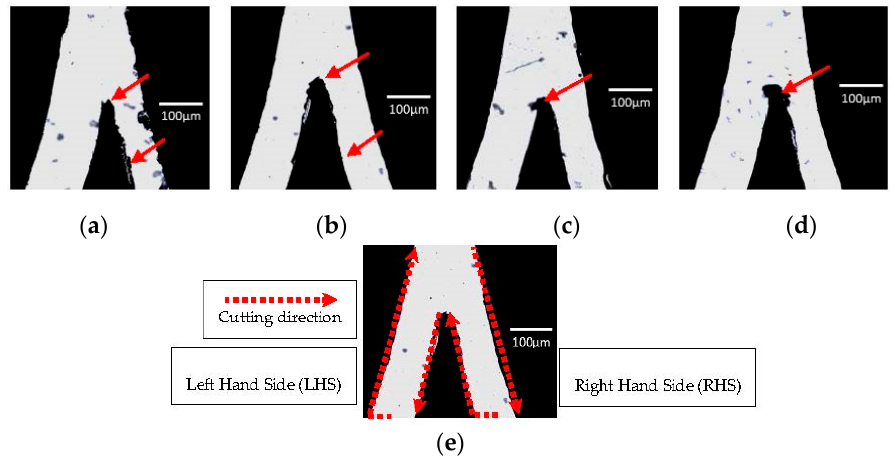
Figure 3. ( a ) Undercut vinyl film at the cutting force of 5; ( b ) vinyl film with the optimal cutting force of 12; ( c ) overcut vinyl film at the cutting force of 13; and ( d ) overcut vinyl film at the cutting force of 20, where the red arrows indicate the locations to be noticed on the sharpness of the cutting edge and the microchannel smoothness; and ( e ) the moving direction of the cutter blade when producing a microchannel. Table 1. Relationship between the cutting force and the Y-curvature junction channel width. Cutting